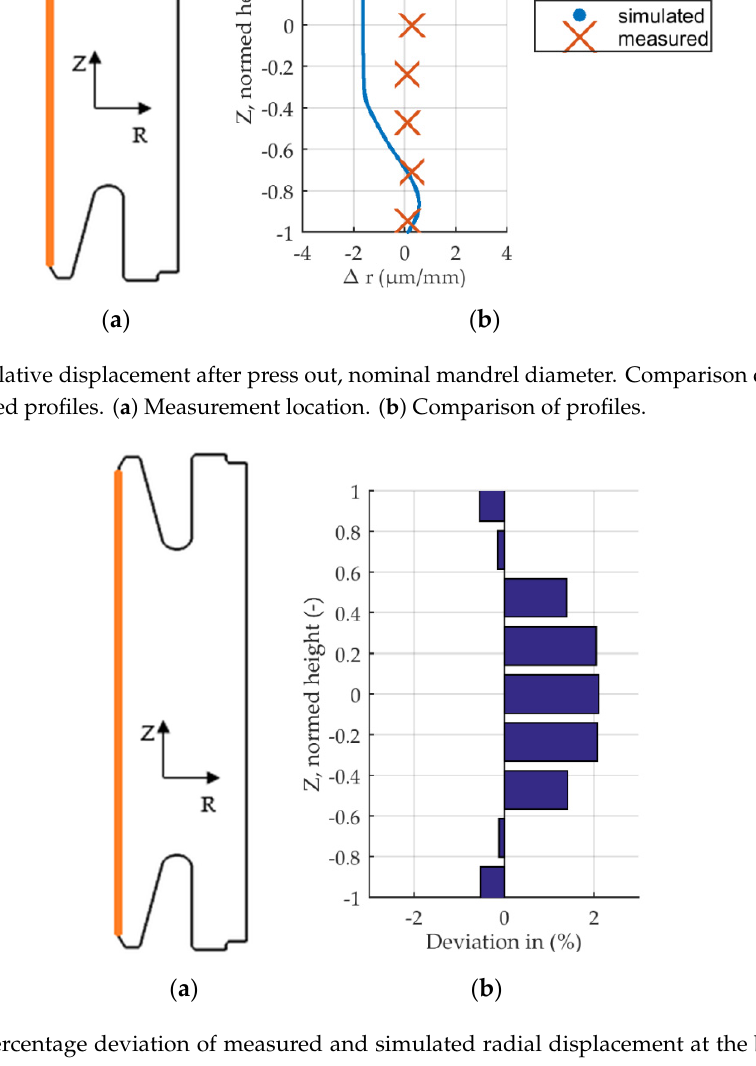
Figure 9. Percentage deviation of measured and simulated radial displacement at the bore at nine measurement positions. ( a ) Measurement location. ( b ) Percentage deviation of displacement.